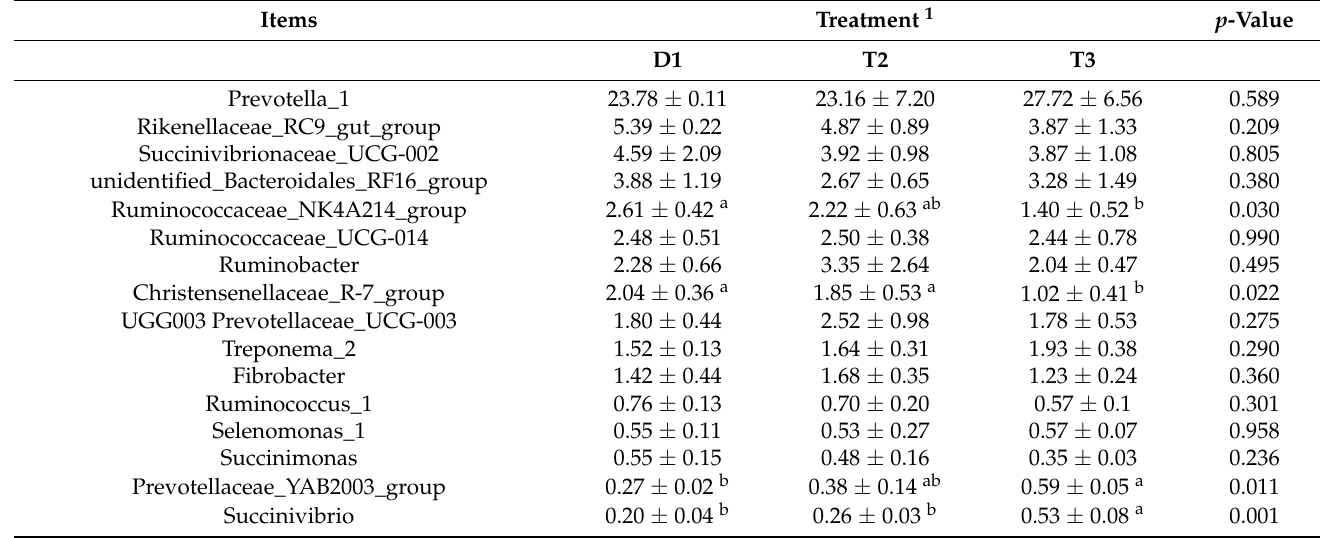
Table 8. Effects of low-protein dietary inclusion of RPLys and RPMet on bacterial genus in the rumen fluids of Holstein